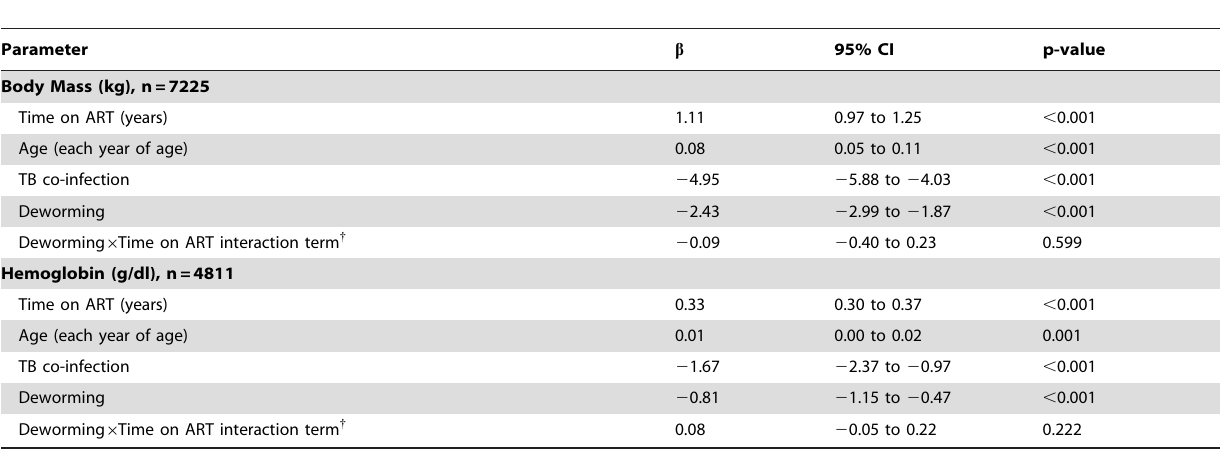
Table 4. Secondary analysis: multivariable linear regression modeling of predictors of body mass and blood hemoglobin